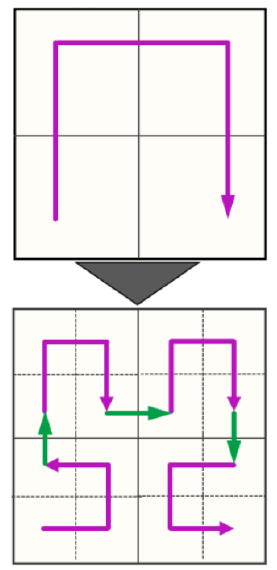
Figure 3. Hilbert space-filling